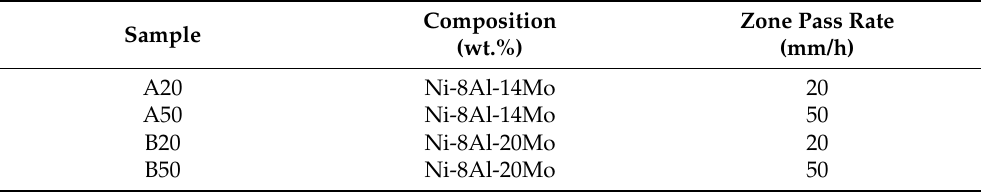
Table 1. Characterization of prepared alloys and sample identification.